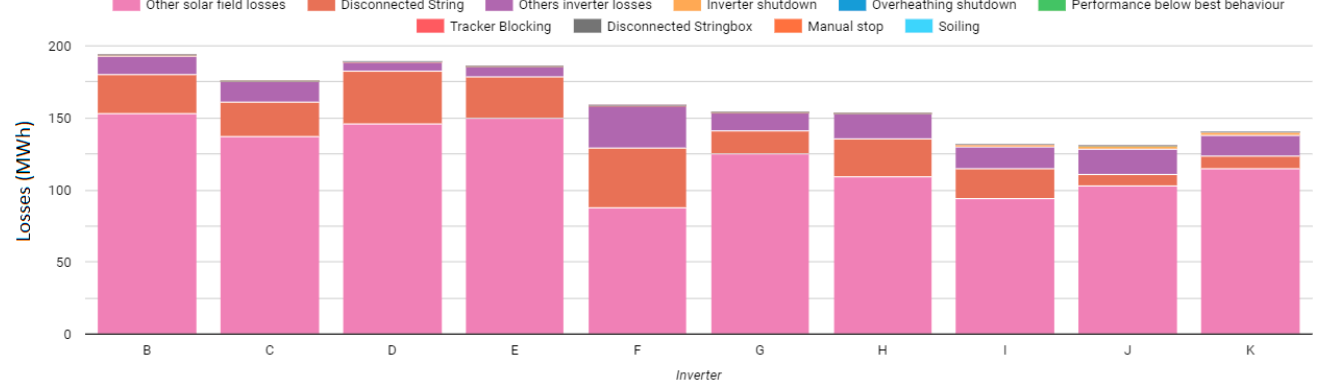
Figure 18. Detected incidents, amount and type of energy loss (depicted by different colors) at the inverter level over the evaluation period.